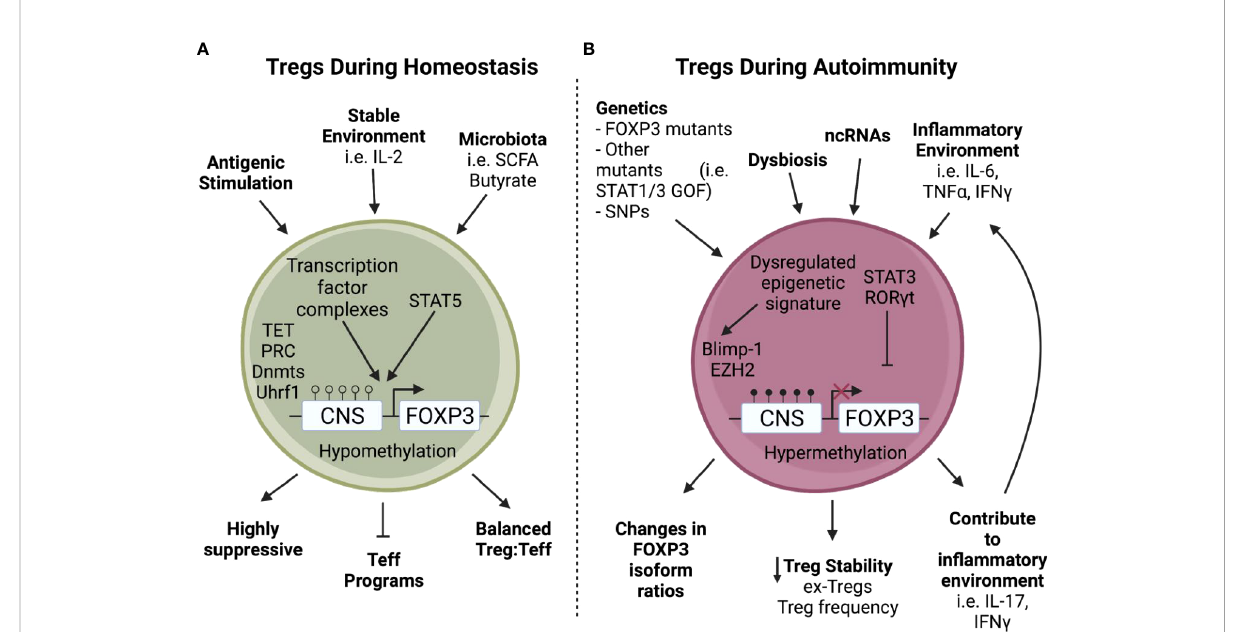
FIGURE 1 Tregs encounter increased stressors during autoimmunity. A) During homeostasis, Tregs are stimulated through TCR activation and proliferate using IL-2 from the surrounding environment (1, 5), allowing downstream transcription factor complexes to bind to a hypomethylated Foxp3 and enact critical Treg functions such as suppressive capabilities and repression of Teff programming (15 – 18). B) In contrast, Tregs found during autoimmunity often have intrinsic defects in addition to environmental stressors (2, 12 – 14, 19 – 23). For example, non-coding RNAs can be dysregulated during autoimmunity (24 – 26) leading to a dysregulated epigenetic signature with increased methylation of the Foxp3 Treg Speci fi c Demethylated Region (TSDR) which can cause a loss of Foxp3 (27). In addition, a tissue environment rich in in fl ammatory cytokines can convert Tregs into Th17-like cells leading to the creation of ex-Tregs and decreased Treg stability (32 – 34). Furthermore, these stressors encountered during autoimmunity can also lead to perturbations in FOXP3 isoform ratios (35, 36) and expression of in fl ammatory cytokines (32, 33) which in turn leads to decreased Treg